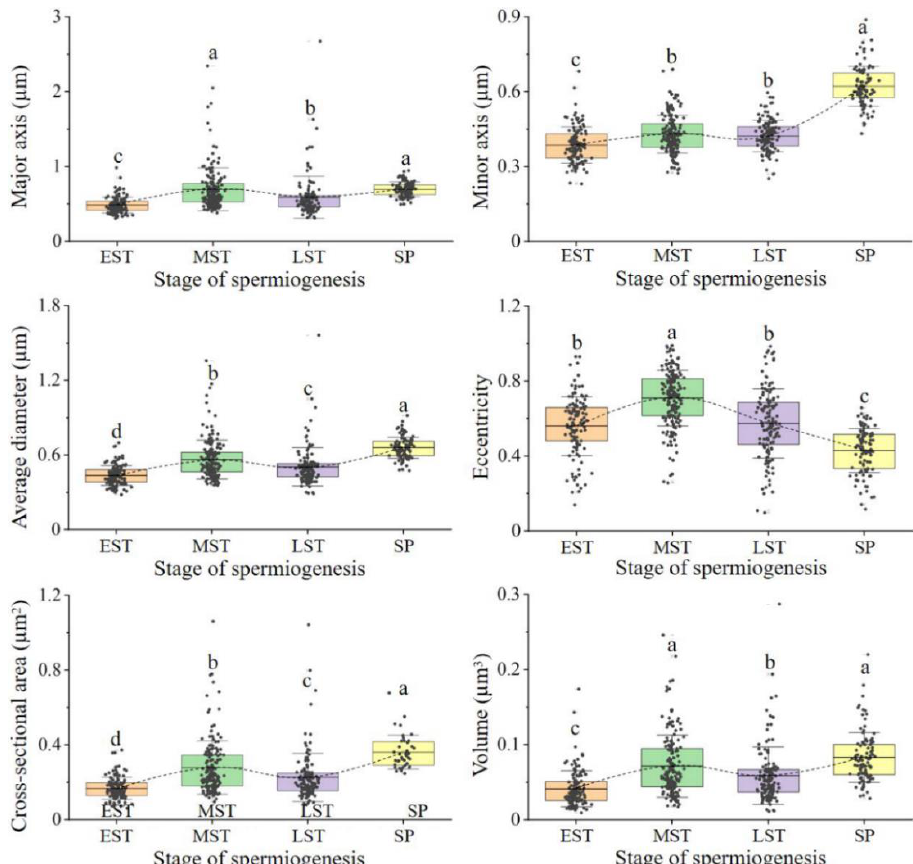
Figure 2. Mitochondrial major axis length, minor axis length, average diameter, eccentricity, cross- sectional area, and volume during spermiogenesis. Different letters above columns indicate significant differences ( p < 0.05). EST: early spermatid, MST: middle spermatid, LST: late spermatid, SP: sperm.